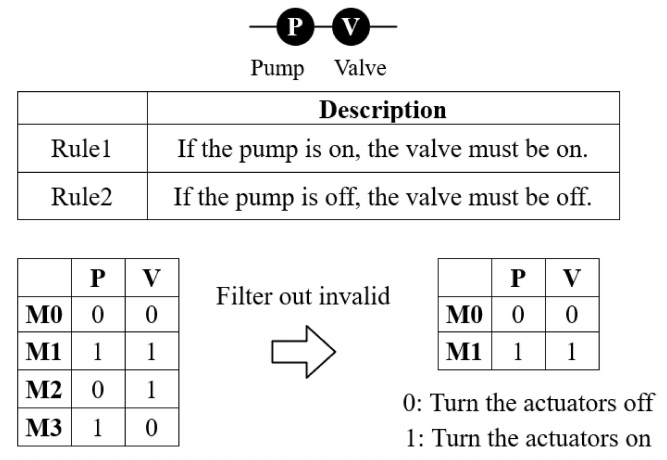
Figure 2. Strategy of the MODI